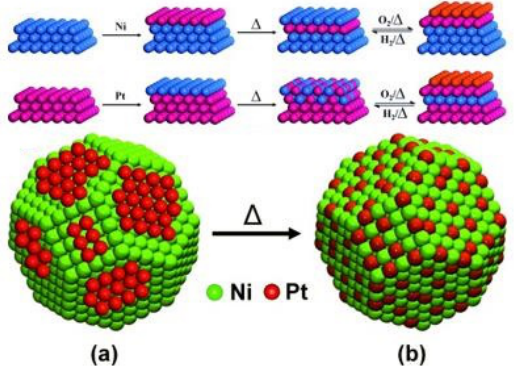
Figure 6. ( a ) Surface restructuring of Ni/Pt bimetallic systems induced by temperature and adsorbates. ( b ) Evolution of the surface structure of the Ni/Pt bimetallic NPs upon thermal treatment. Reproduced with permission from reference [119].